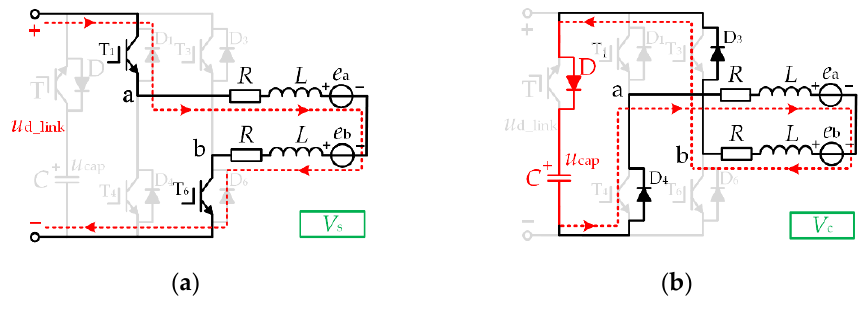
Figure 5. Vector equivalent circuit ( a ) V s ( b ) V c .